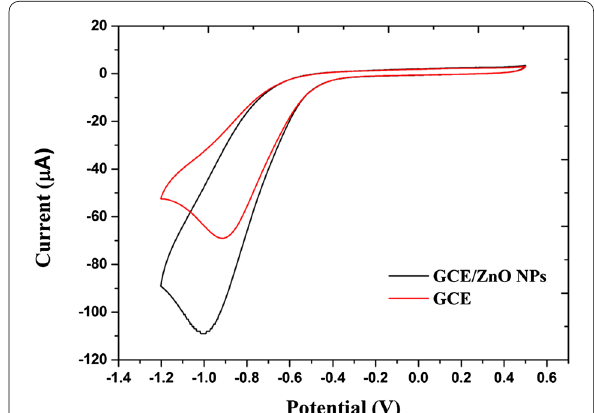
Fig. 3 CV curves of 3TC in 0.1 M PBS (pH 7) on GCE and GCE/ZnO NPs at the scan rate of 100